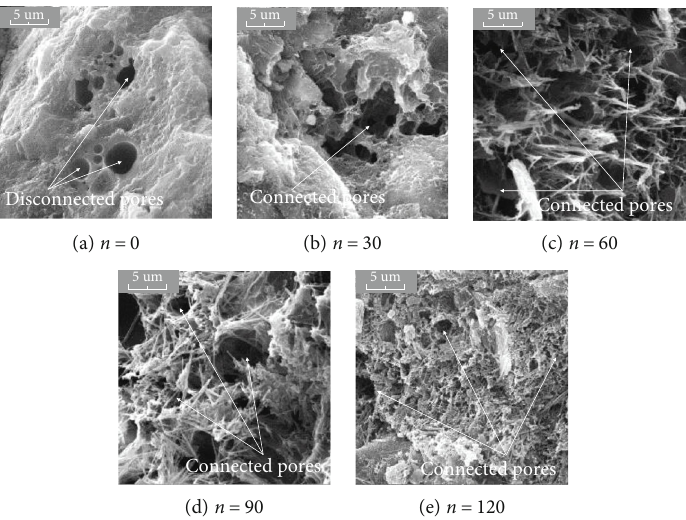
Figure 5: Pore characteristics of concrete after increasing numbers freeze-thaw cycles ( m = 35 % ).